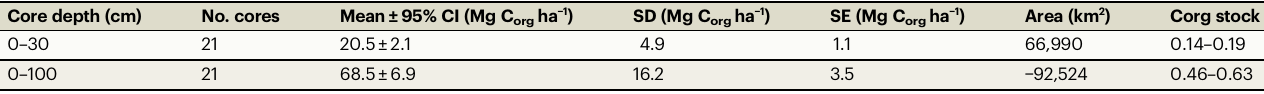
Table 1 | Sediment C org stocks in Bahamas seagrass ecosystems